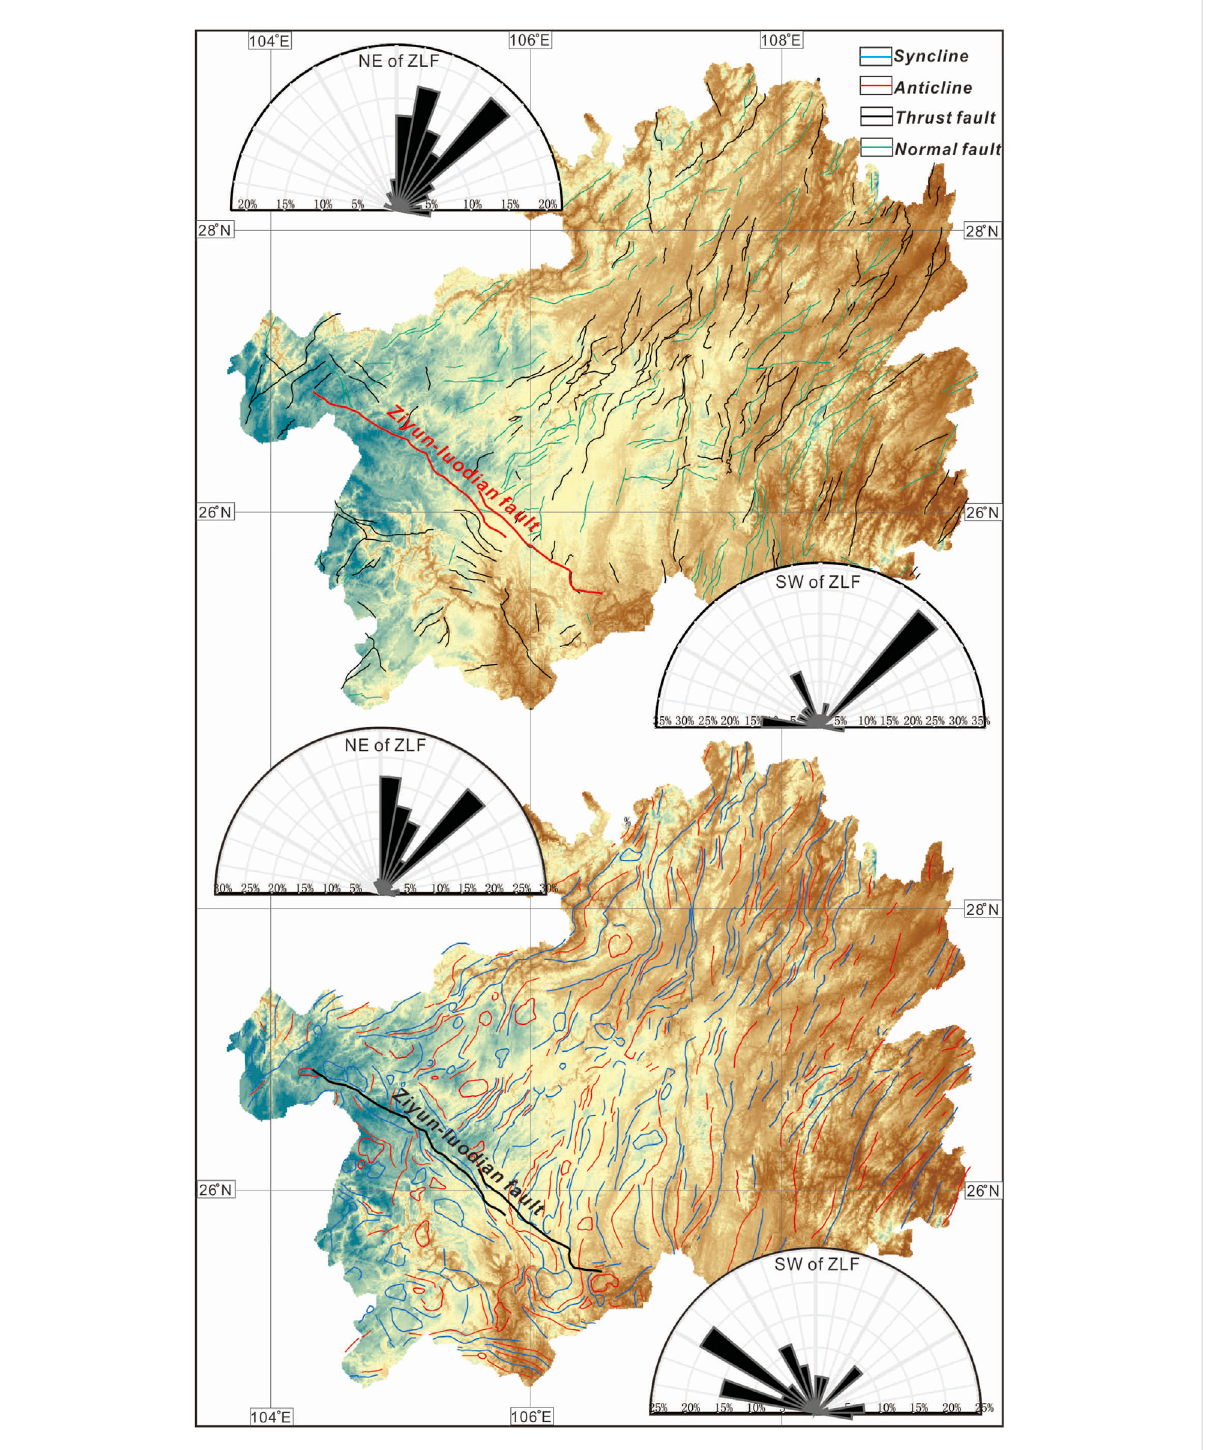
Structural pattern of the Guizhou